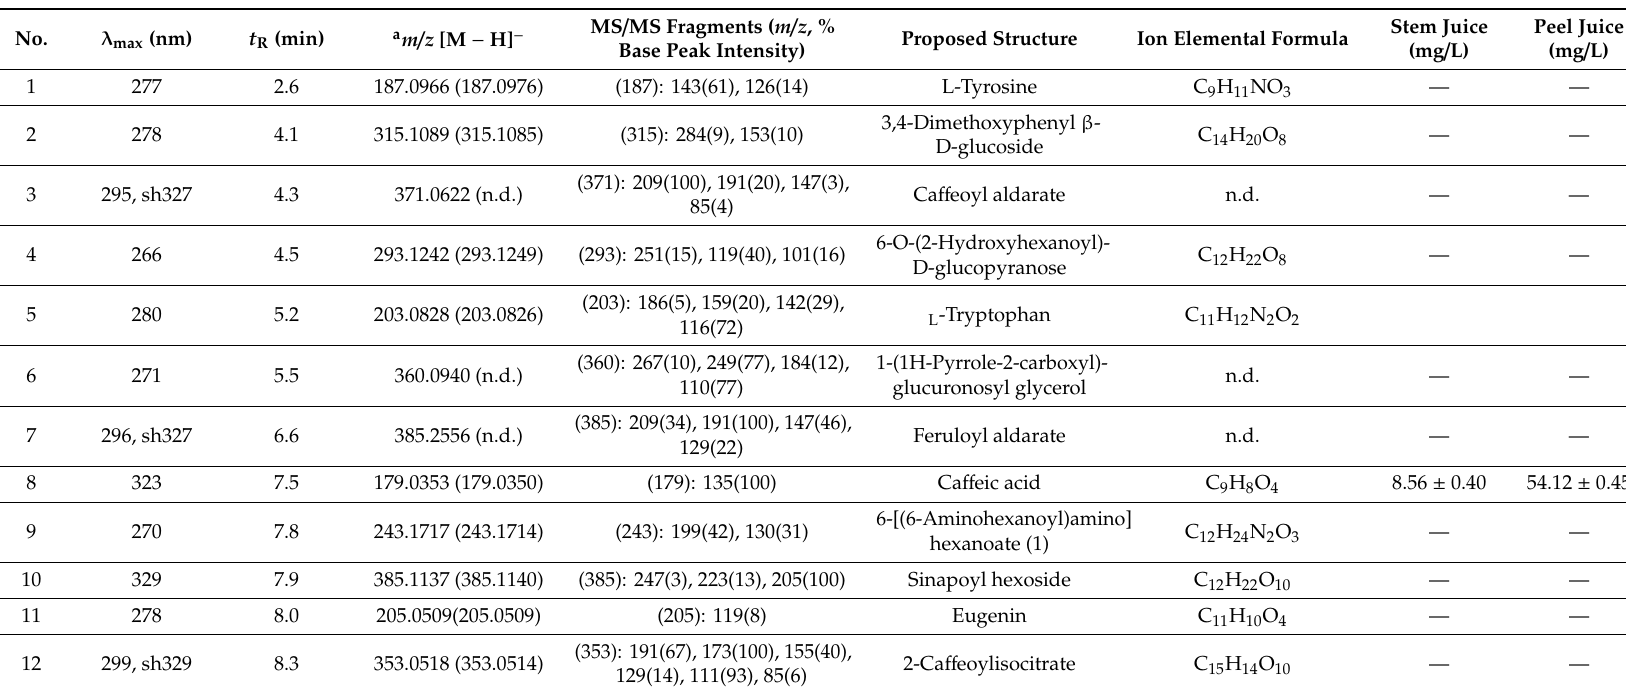
Table 6. LC-ESI-UHR-QqTOF-MS data of phenolic compounds and other metabolites in fresh by-products pineapple liquid fraction. Identification and quantification of the predicted compounds by UPLC